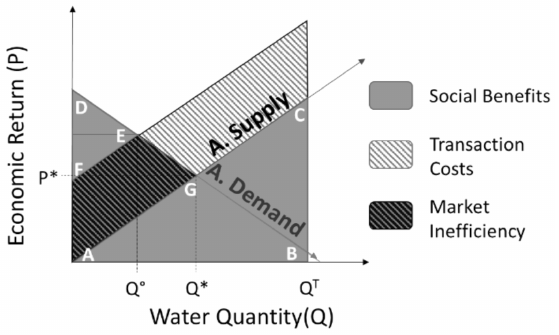
Figure 3. Water economic model. Relationship among water volume (Q), economic return (P), transaction costs, social benefits, and market inefficiency. The superscripts * , ◦ indicate points of equilibrium, and the superscript T represents the maximum water availability for the season. The letters A-G represent vertices of zones or sub-zones of the market that will be analyzed later. Adapted from